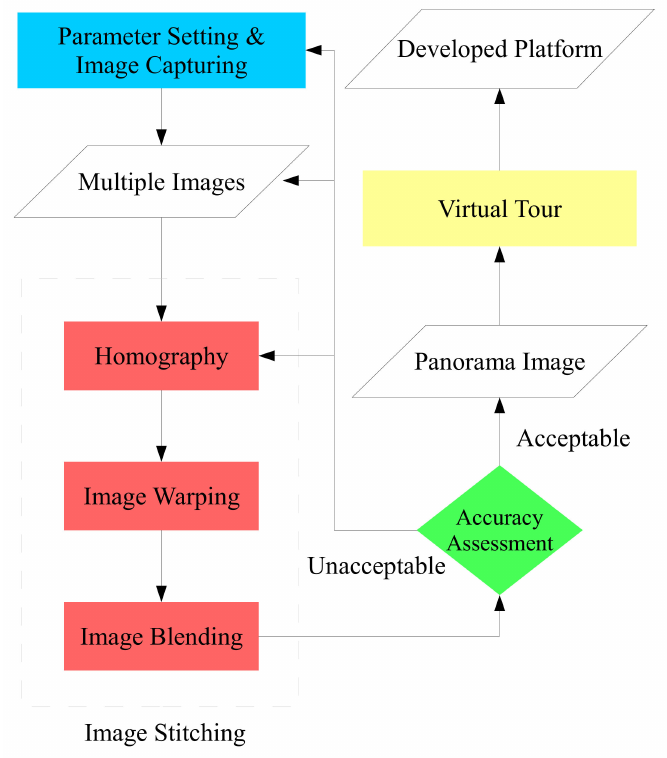
Figure 2. Study procedure (each color will be presented in the same